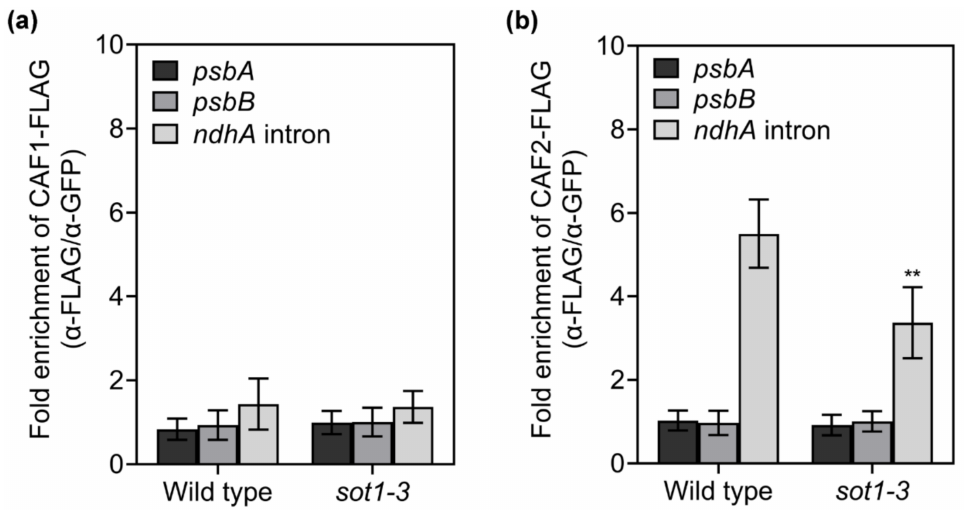
Figure 9. The loss of SOT1 results in the decreased association of CAF2 with the ndhA intron. The C-terminal FLAG fusion of CAF1 or CAF2 was expressed in protoplasts isolated from 12-day-old WT and sot1-3 seedlings. Chloroplasts were harvested from the transfected protoplasts. The relative transcript levels of the psbA , psbB , and ndhA introns in α -FLAG immunoprecipitated complexes were determined via qPCR. Student’s t -test was carried out to determine the significance of the fold enrichments of CAF2 on ndhA intron between WT and sot1-3 plants. ** indicates a significant difference at p < 0.01. Mean values ± SD of the triplicate replicates are